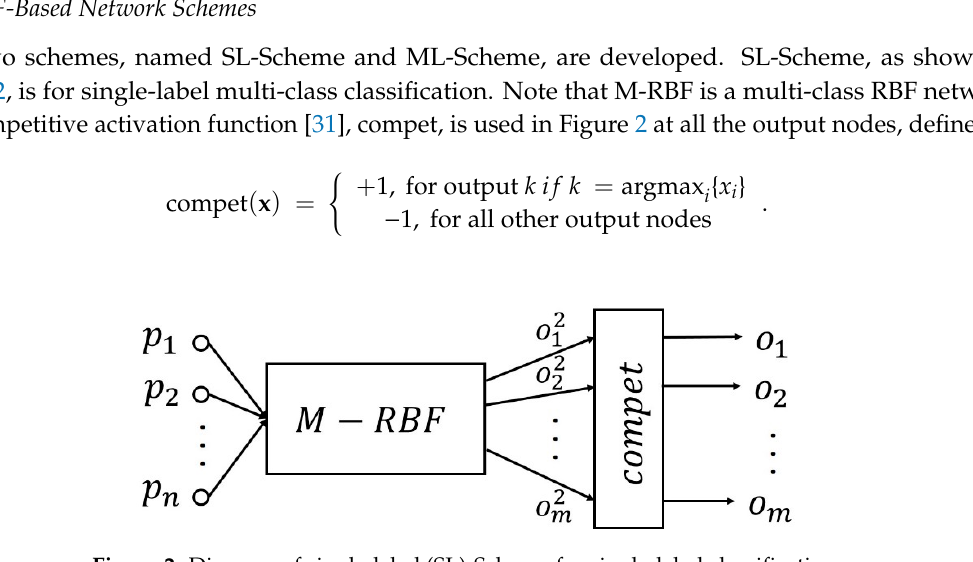
Figure 2. Diagram of single-label (SL)-Scheme for single-label classification.